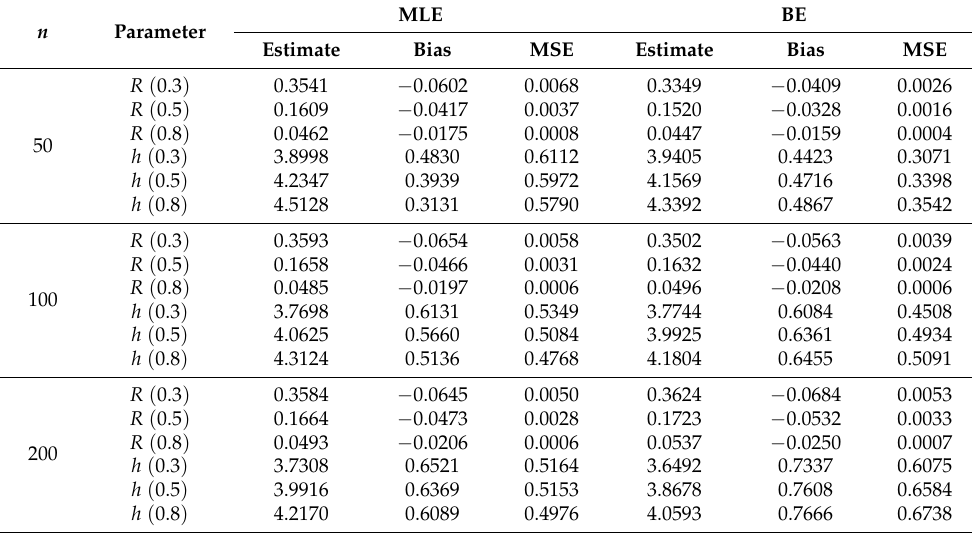
Table 9. Point estimates of R ( x ) and h ( x ) at x = { 0.3,0.5,0.8 } under Scheme 3.